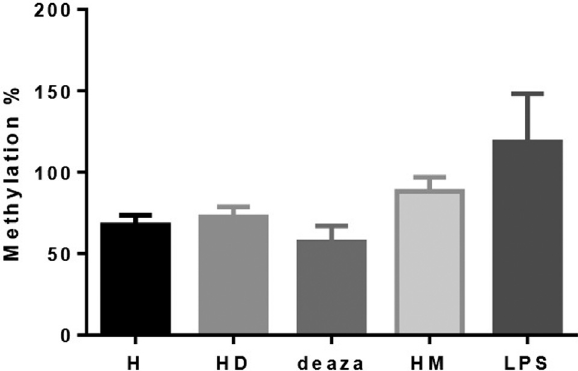
Figure 2 - Relative expression results of different cell culture models. The 1-3 are exon 2 spliced transcripts’ expressions and 2-3 exon 2 containing transcripts’ expressions. H: untreated HL-60 cells; HD: HL-60 cells dif- ferentiatedtoneutrophil-likecellsviaDMSO;deaza:demethylatedHL-60 cells using deazacytidine; HM: methylated HL-60 cells with methanol; LPS: HL-60 cells activated through PMA & LPS. The expression compar- isons were significant with p < 0.0001 for H vs. HM, p = 0.0005 for H vs. HD, p = 0.0034 for H vs. LPS and p = 0.0126 for H vs. deaza (p < 0.05 was considered statistically significant, N = 4 for each cell model).